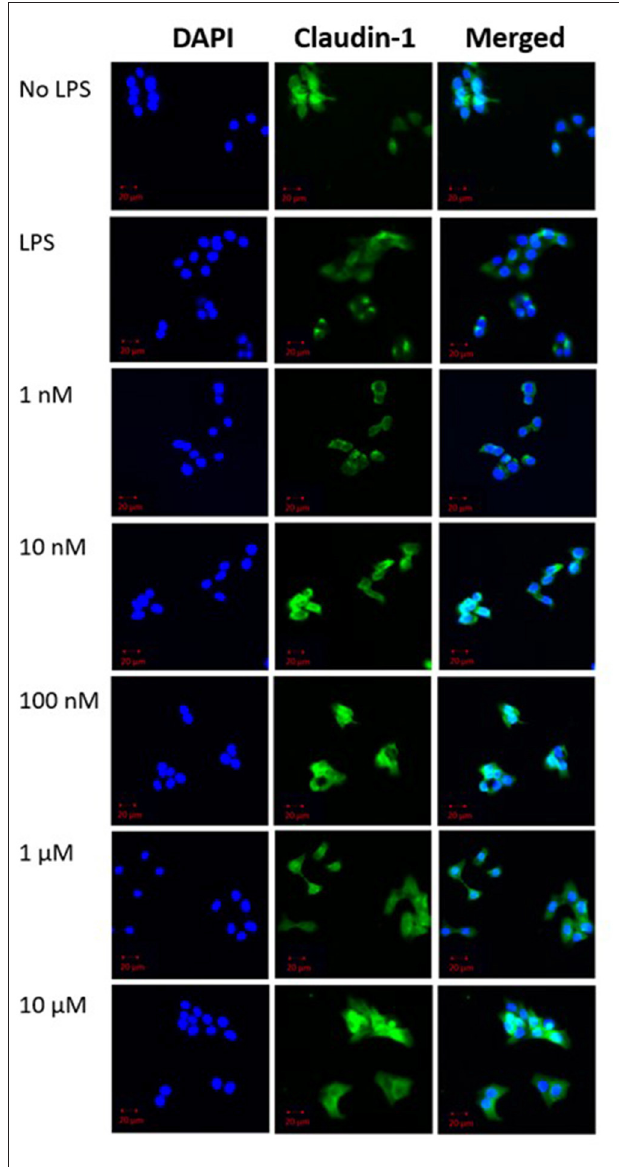
FIGURE 3 | β -Carotene promotes claudin-1 protein expression. Confocal microscope images of claudin-1 protein expression. (DAPI panel) HT-29 cell nuclei indicated via DAPI staining. (Claudin-1 panel) Protein expression of claudin-1 expression portrayed by fluorescent staining via Alexa Fluor 488. Panels are merged in the final panel for visualization of localization. Five treatment doses of β -carotene (1, 10, 100nM, 1, 10 µ M). Scale bar of 20 µ m was included for size